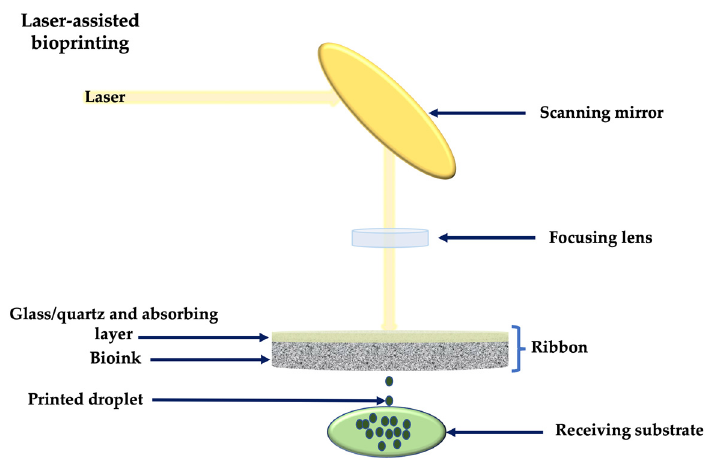
Figure 3. Laser-assisted bioprinting.